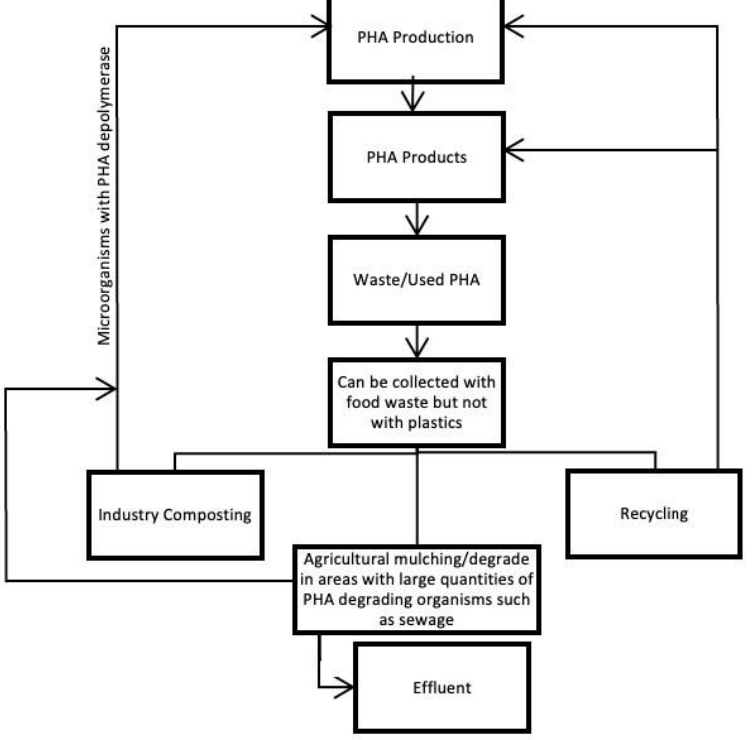
Figure 15. Waste management process of PHA. Adapted from “Bioplastics: A boon or bane?”, Renewable and Sustainable Energy Reviews, vol. 147. Elsevier Ltd., 1 September 2021 Figure 15. W aste management process of PHA. Adapted from “Bioplastics: A boon or bane?,” , Re- newable and Sustainable Energy Reviews, vol. 147. Elsevier Ltd., Sep. 01, 2021. doi: 10.1016/j.rser.2021.111237 [31].